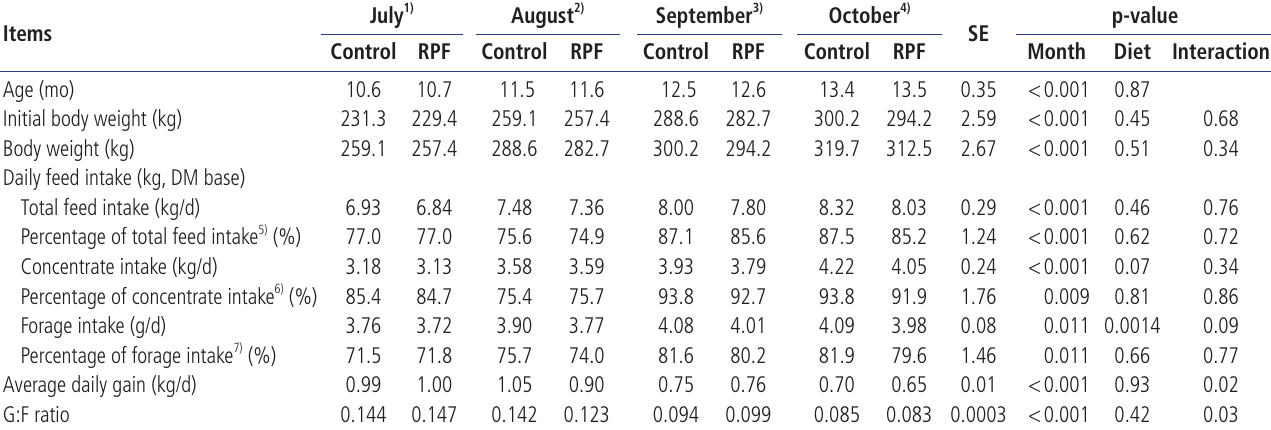
Average daily gain (kg/d)